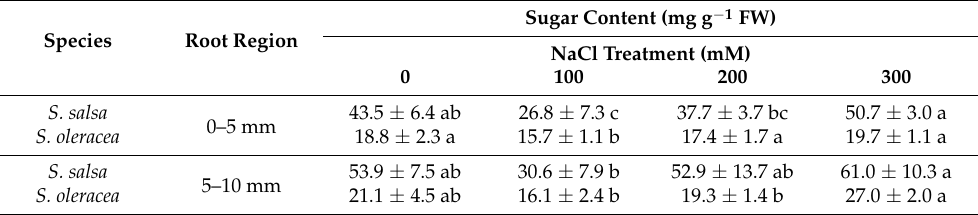
Table 1. Total sugar content in the cell wall of the 0–5 mm and 5–10 mm root segments in S. salsa and S. oleracea young seedlings grown under different concentrations of NaCl. Data indicate mean ± S.D. ( n = 4). Species